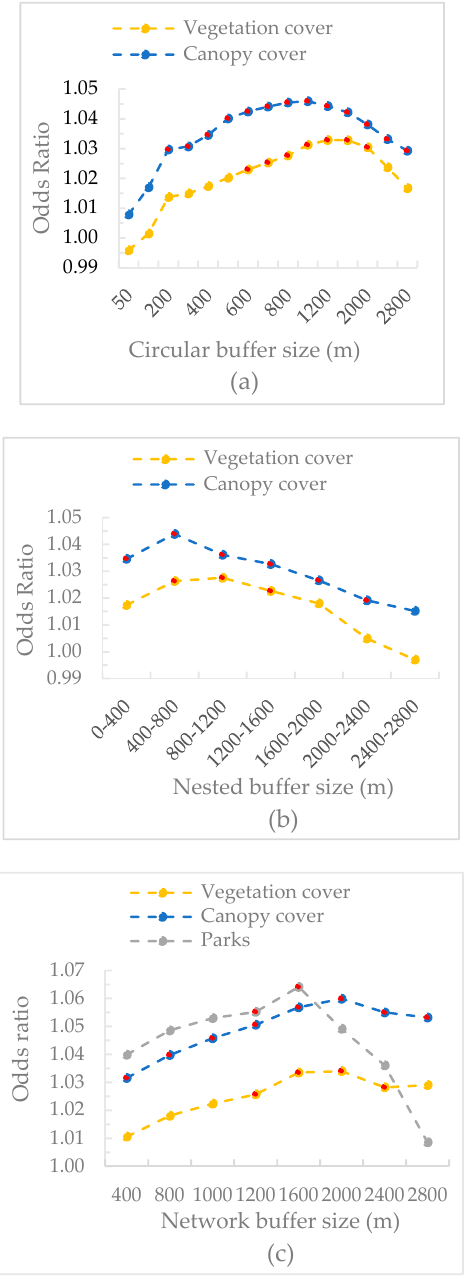
Figure 4. The associations between UGS quantity and mental health at circular buffers ( a ), nested buffers ( b ), and network buffers ( c ) (red dots are significant results at the significant level of